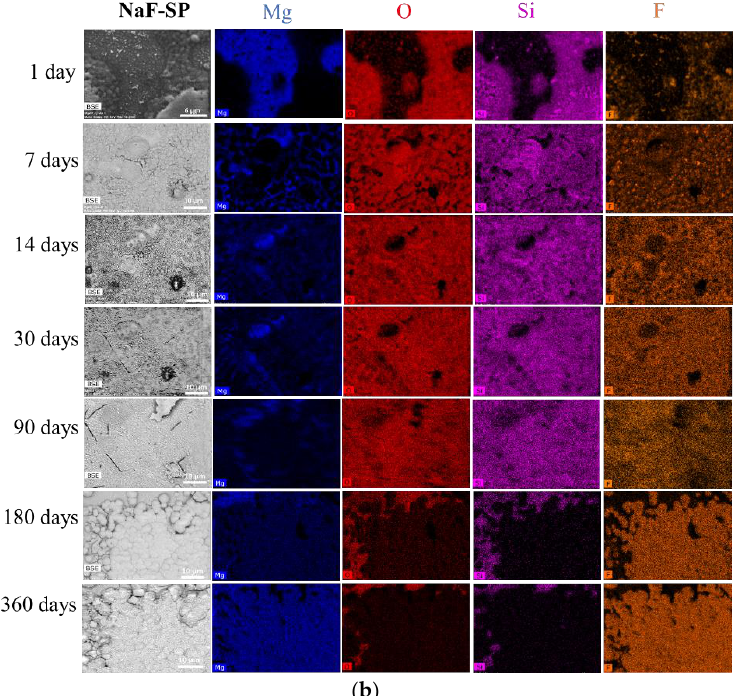
Figure 2. SEM images of the corroded MgZr substrates in ( a ) poral solution (PS) and ( b ) NaF-PS as a function of corrosion time and corresponding EDX cartographies.